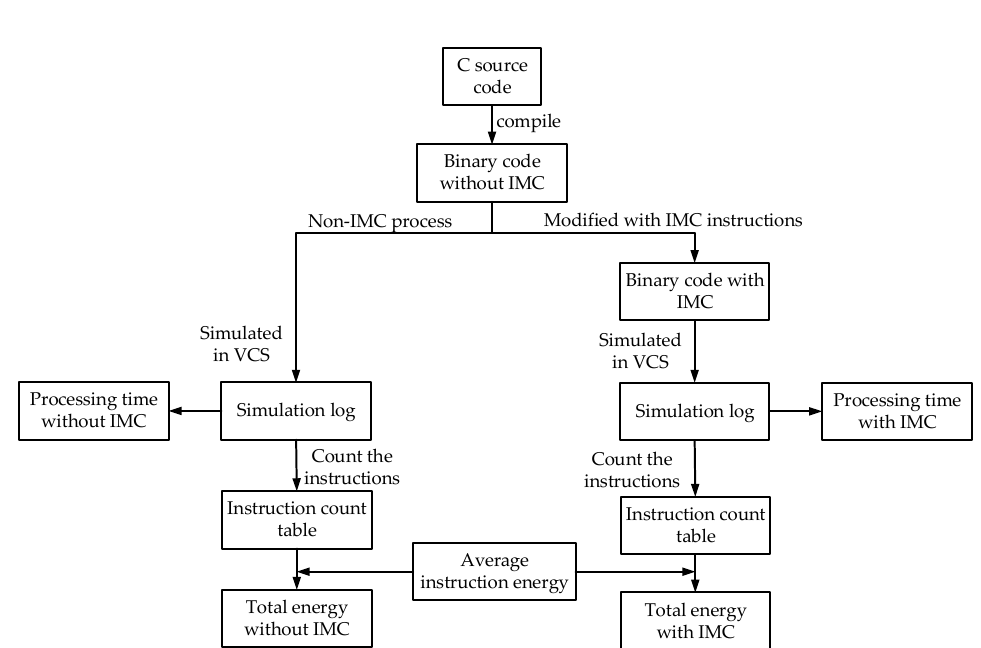
Figure 6. Evaluation method for processing time and energy consumption.